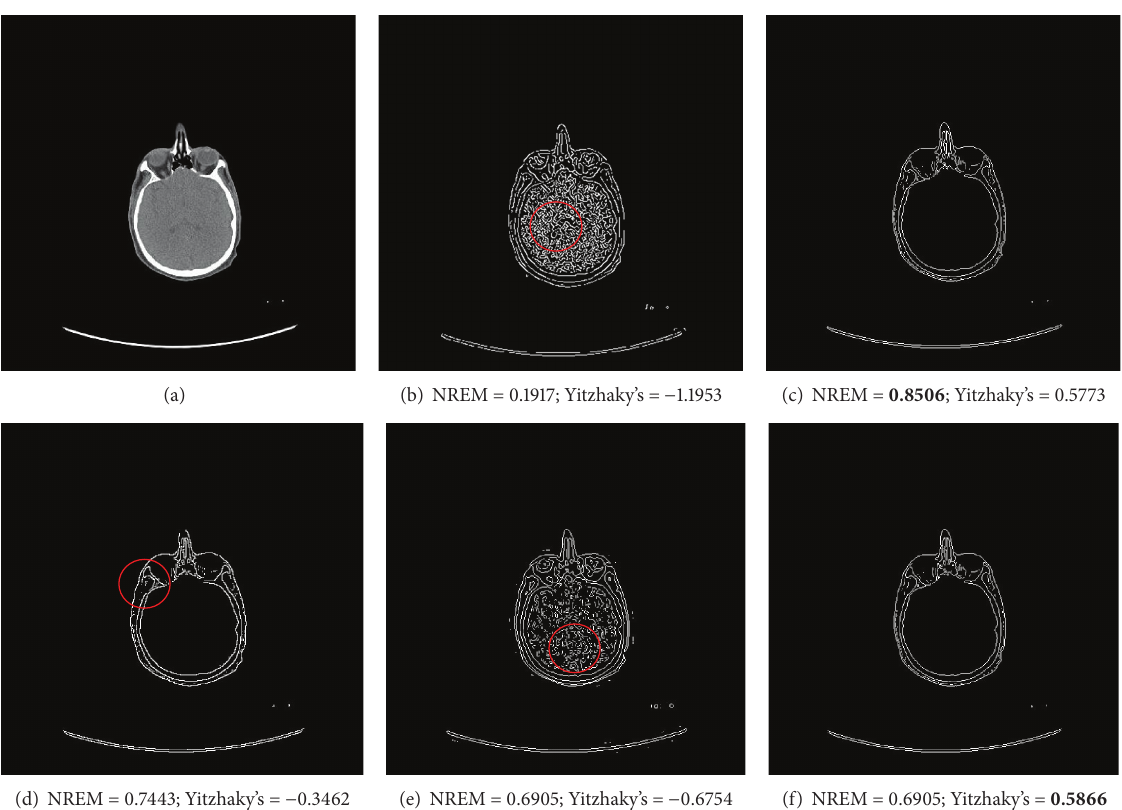
Figure 3: Using measures to select optimal edge detection algorithms. (a) Original CT abdomen image. (b)–(f) Edge detection results from (b) Canny, (c) Sobel, (d) Roberts, (e) LoG, and(f) Prewitt. The optimal edge maps with highest NREM value and Yitzhaky’s measure value are in